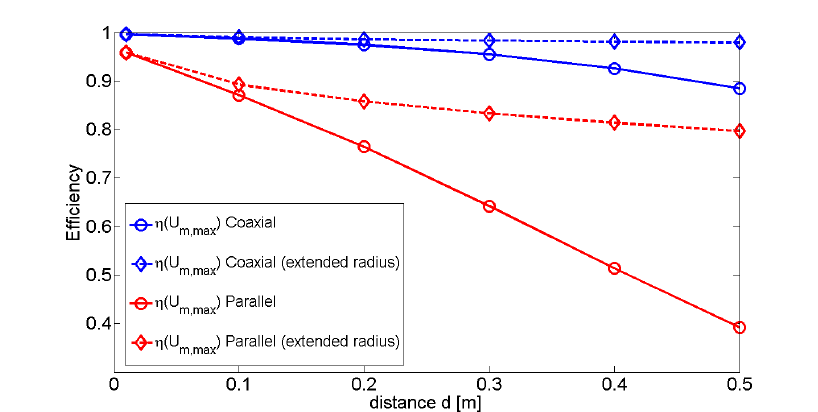
Figure 10. Efficiencies for each configuration of the loop system when operating at U